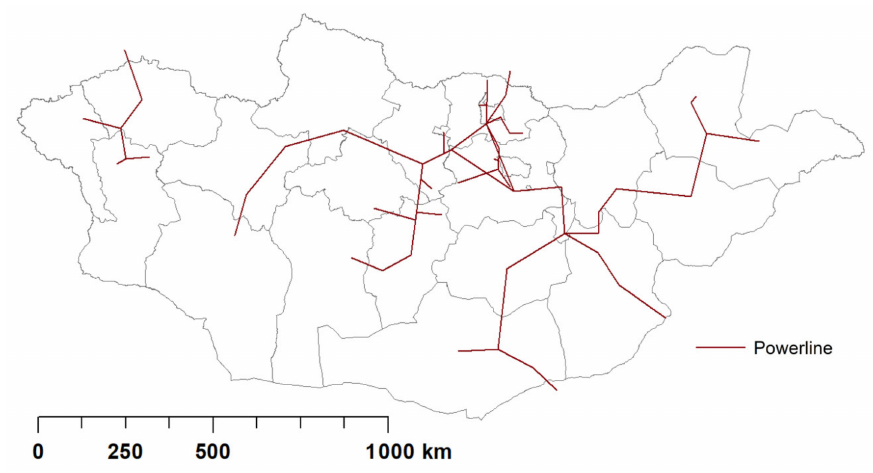
Figure 9. Major power transmission lines in